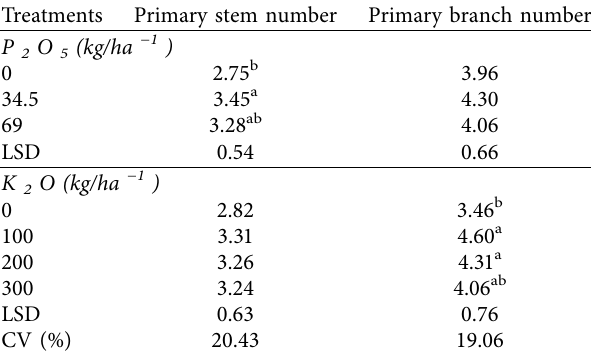
Table 3: Growth components of potato as influenced by phos- phorus and potassium fertilizer